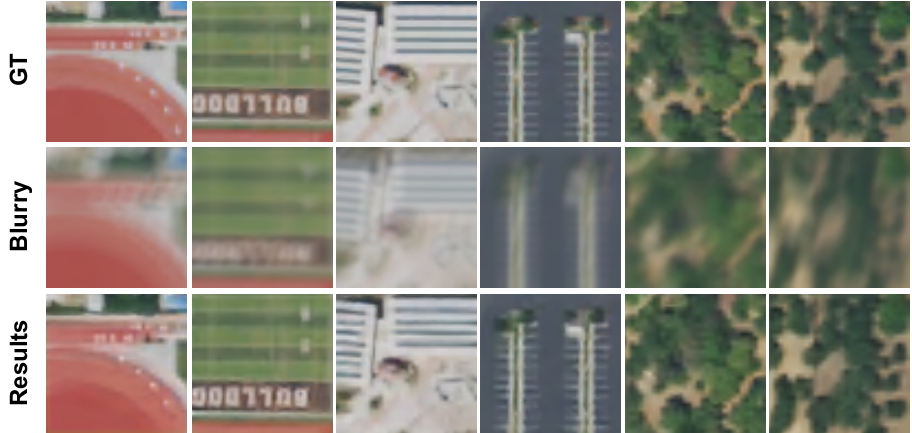
Figure 11. The images restored by Ref-MFFDN of size 64 × 64 pixels.